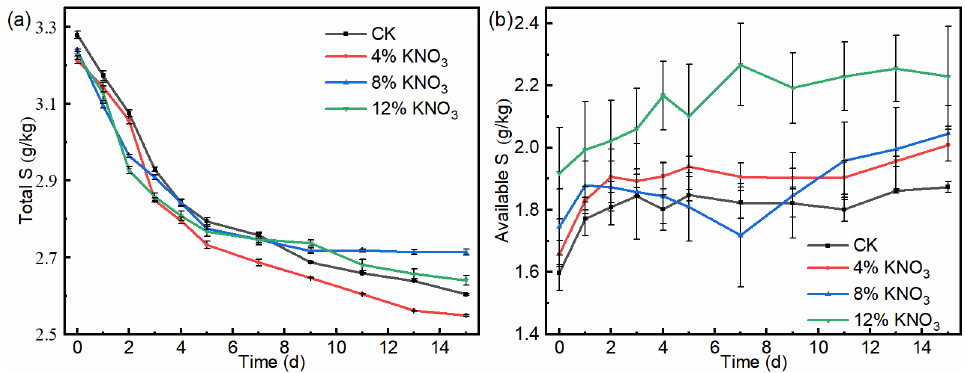
Figure 5. Variation of the total sulfur ( a ) and available sulfur ( b ) contents of the compost material under different KNO 3 additions.